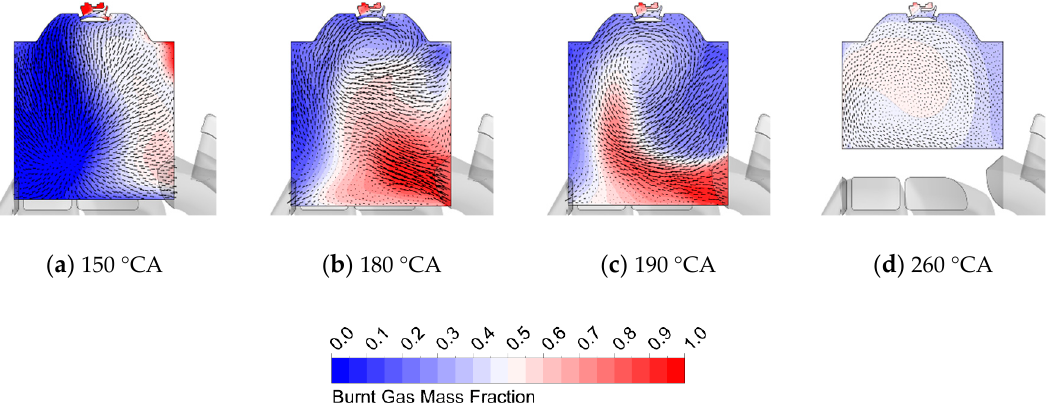
Figure 11. In-cylinder scavenging behavior at 2500 rpm and 10% of load using PN8 prechamber.